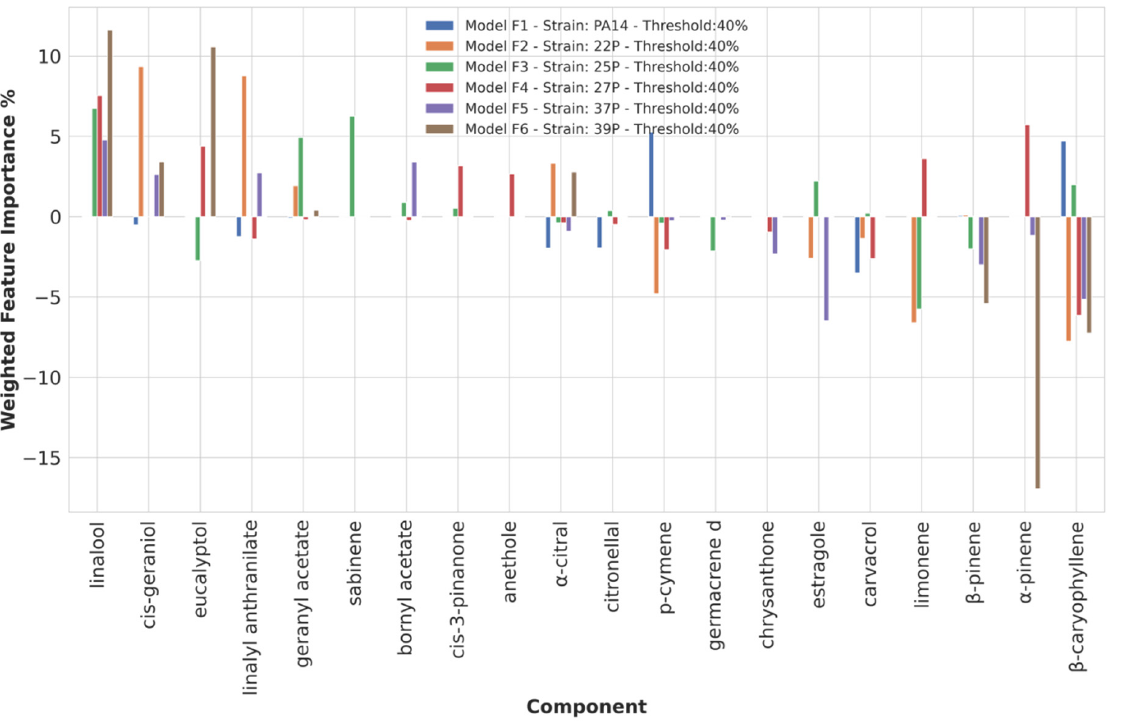
Figure 1. Weighted feature importance (WFI) plot for models F1 to F6 obtained on the dataset binarized at 40% biofilm inhibition. Positive bars are associated with inhibition of biofilm production, whereas negative bars are associated with augmented biofilm production. Only the 10 highest (anti-biofilm) and 10 lowest (pro-biofilm) values are displayed.